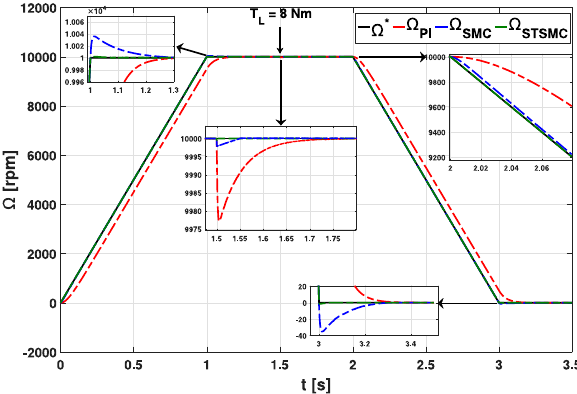
Figure 5. Velocity responses for the designed controllers.